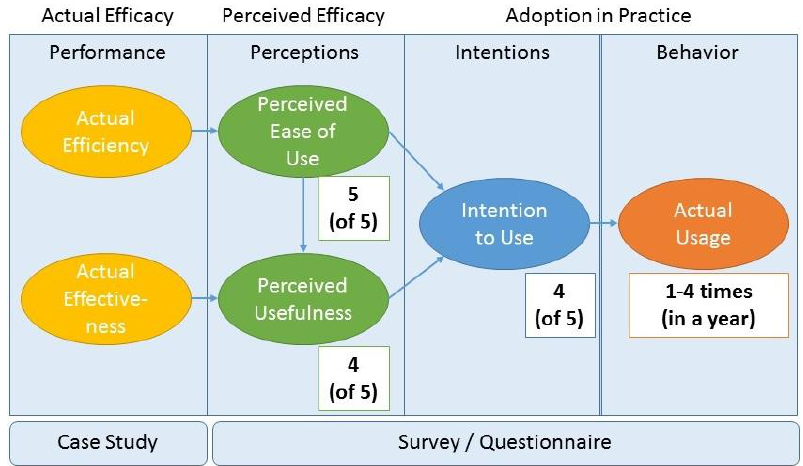
Figure 7. Method evaluation model including average results of the